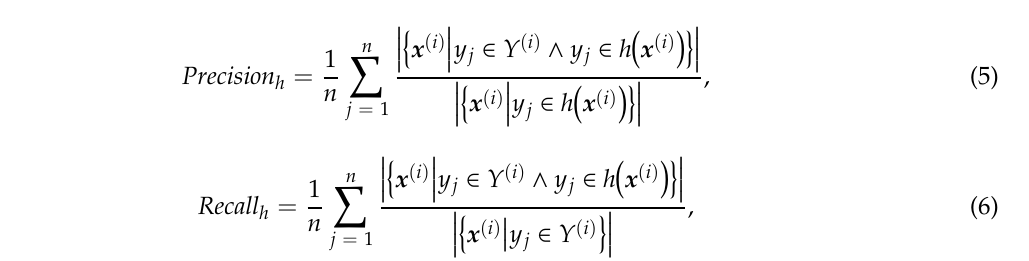
Figure 5. Confusion matrix for validation set of Net- Ⅱ.